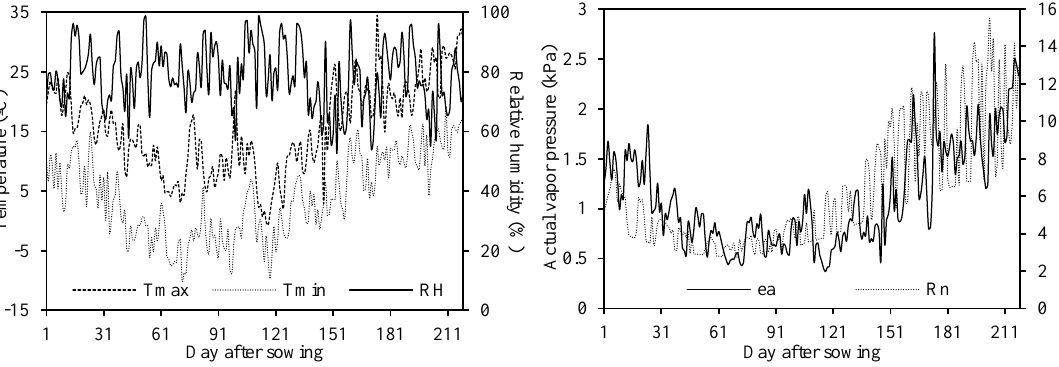
Figure 2. Climatic conditions of the experimental site during the winter wheat whole growth period. T max : maximum air temperature. T min : minimum air temperature. RH : relative humidity. e a : actual vapor pressure. R n : net radiation.